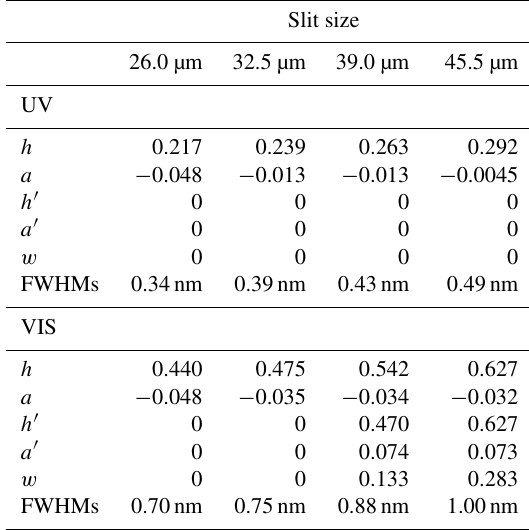
Table 5. Retrieved slit parameters for slit function described